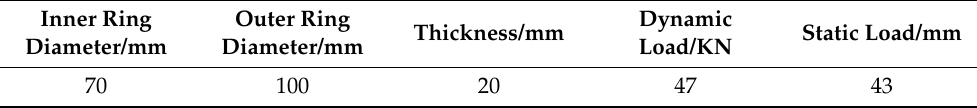
Figure 11. Schematic diagram of bearing structure loading. Table 2. NSK7014C angular contact ball bearing parameters